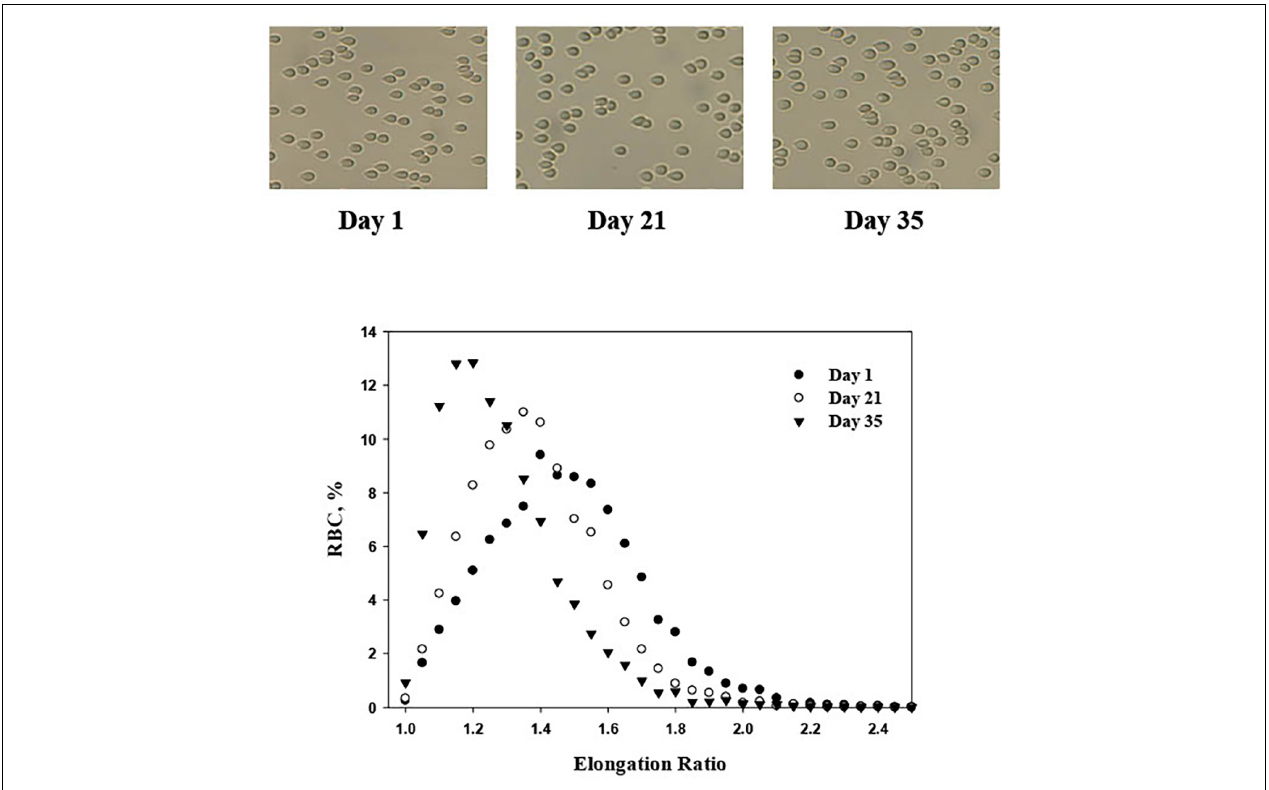
FIGURE 1 | An illustrative micrograph of PRBCs [adhered to glass slide of the flow-chamber (Barshtein et al., 2020b)] under a flow-induced shear stress of 3.0 Pa. Distribution of RBC deformability, expressed by their Elongation Ratio, in RBC population (8’000–10’000 cells), presented by the percentage of RBCs in a discrete elongation ratio